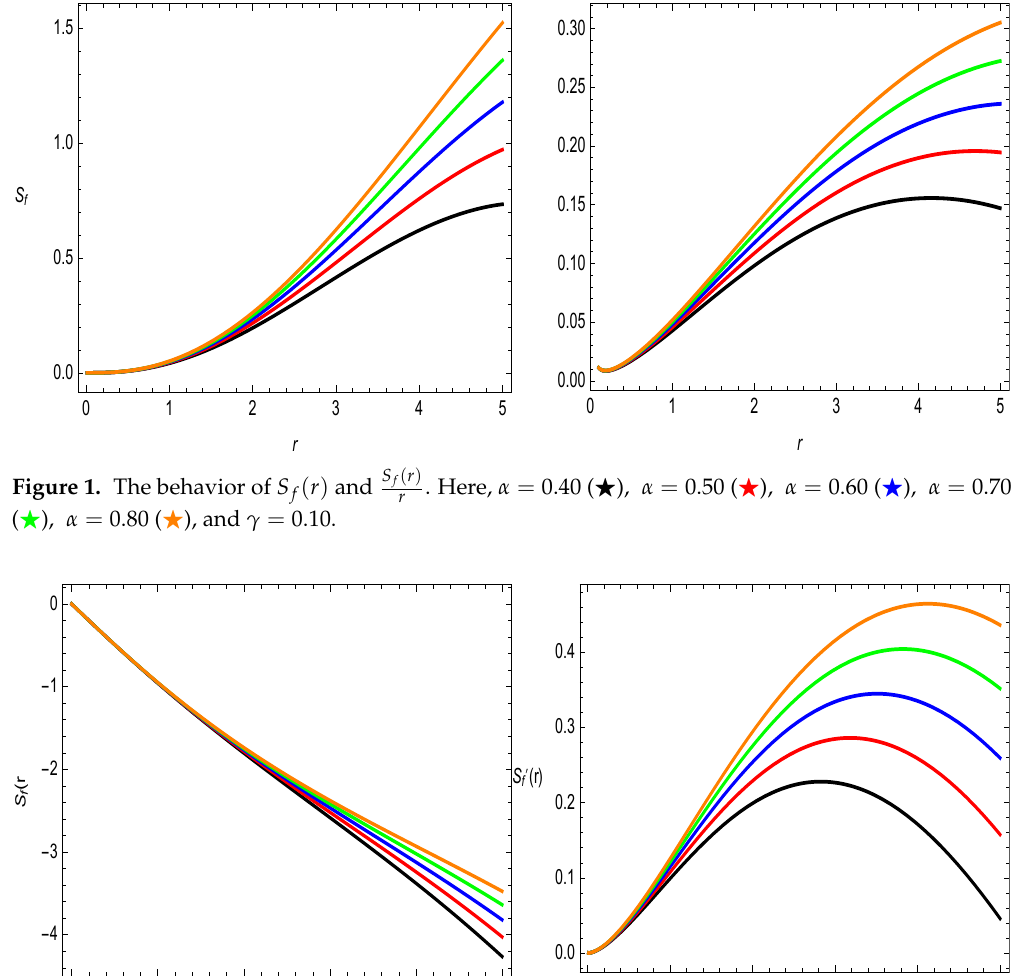
( r ) . Here, α = 0.40 ( (cid:70) ), α = 0.50 ( (cid:70) ), α = 0.60 ( (cid:70) ), f